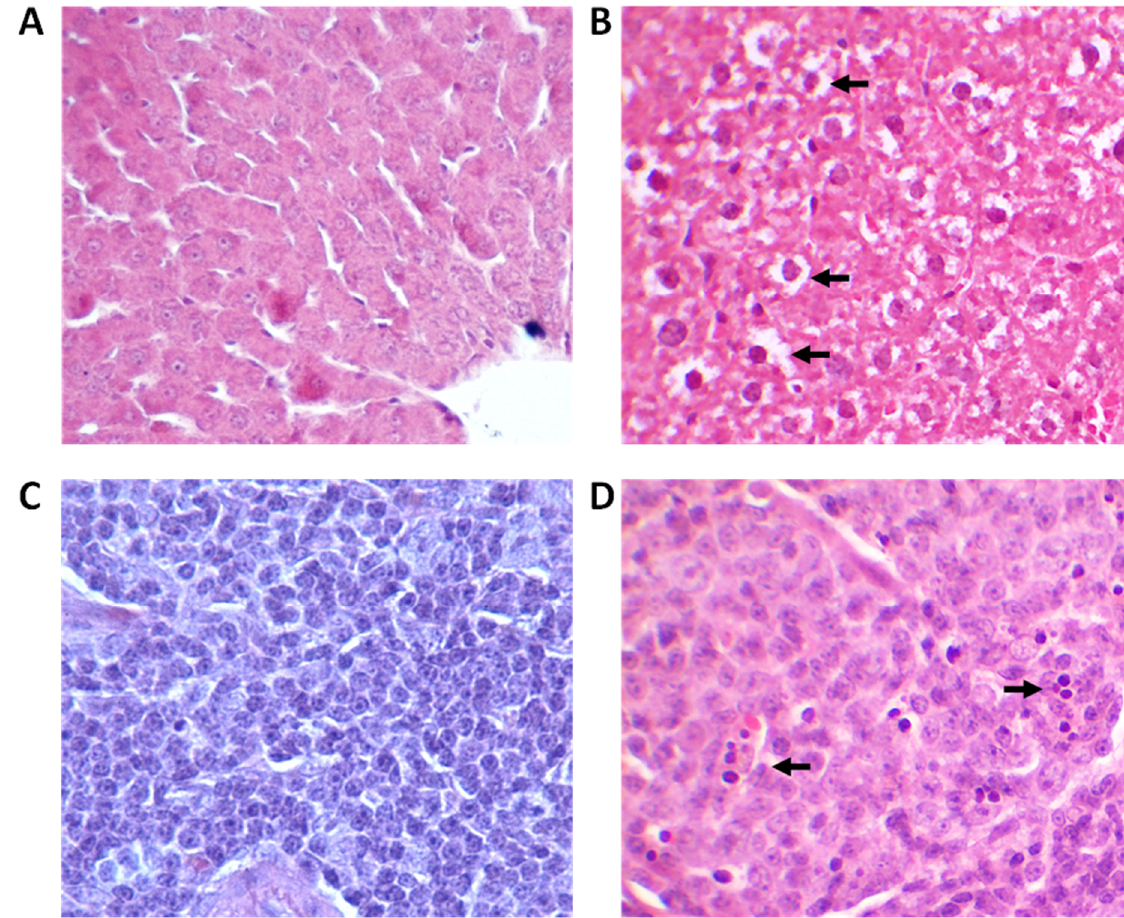
Figure 3. Histopathologic changes detected in rats exposed to the liver ( A , B ) and spleen ( C , D ). Cytoplasmic vacuolation (arrows) observed in rat hepatocytes at 7 days after single i.v. injection of PEG-AuNPs. Hematoxylin-eosin, magnification 20×. Shrinking of cells (arrows) in the splenic white pulp indicating apoptotic morphology observed in rat spleen 24 h after single i.v. injection of PEG-AuNPs. Hematoxylin-eosin, magnification 40×.